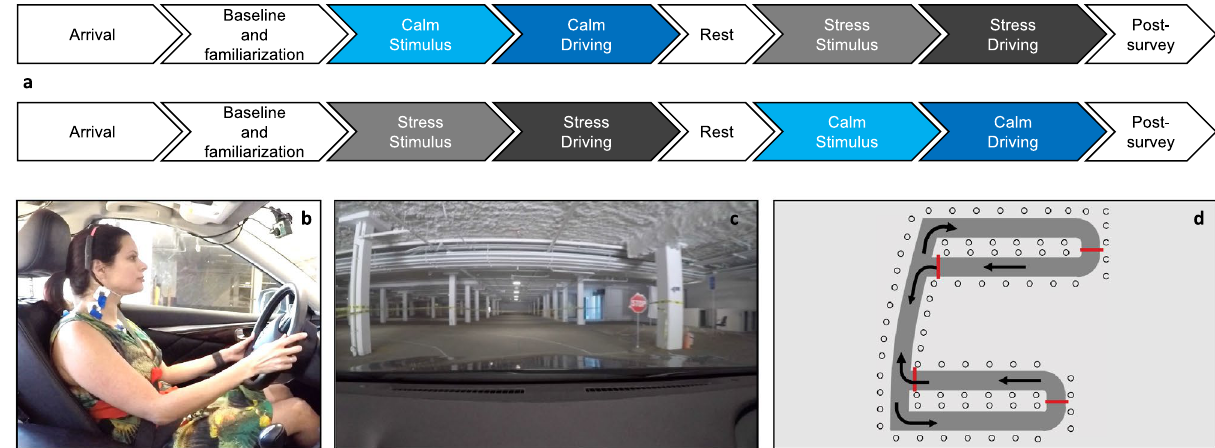
Figure 6. Experimental methodology. Procedure of the experiment ( a ), in which frequent commuters drove in a regular car ( b ), within a large parking garage ( c ), on a fixed 0.65 miles driving course that included eight turns per lap ( d